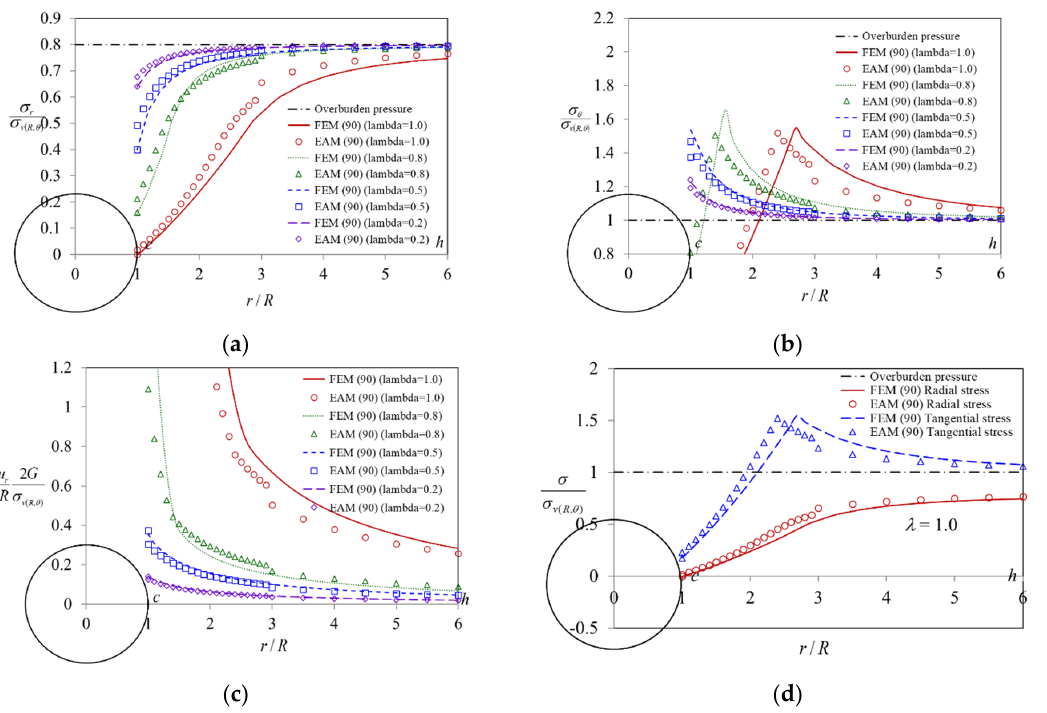
Figure 12. Ground reaction around the tunnel obtained by EAM and FEM with the different incre- mental values λ in an elastoplastic media, and the distribution of ( a ) radial stress, ( b ) tangential stress, ( c ) radial displacement, and ( d ) tangential and radial stresses with λ = 1.0 (Case II and K o = 0.8).